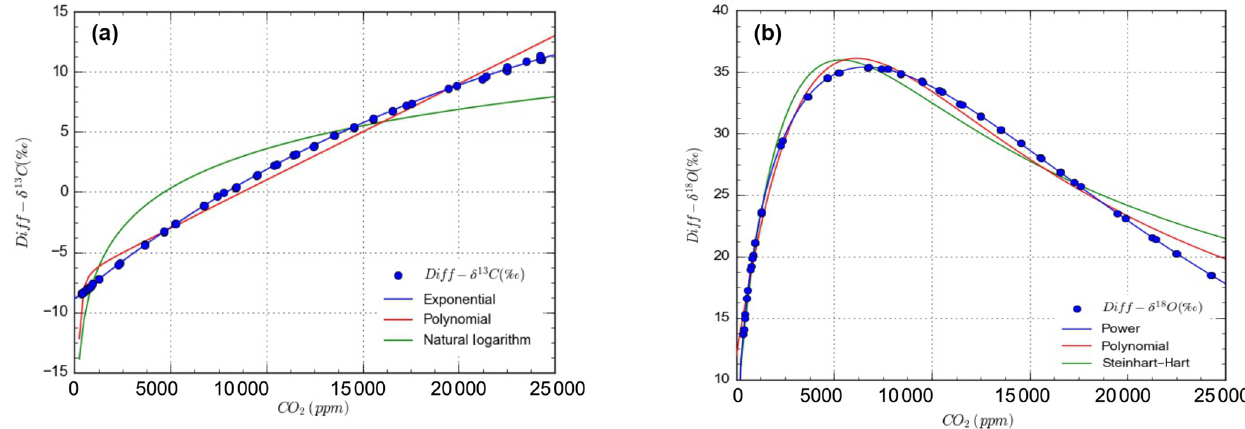
Figure 5. Mathematical models for concentration dependent drift in OA-ICOS measurements of stable isotopes of carbon (a) and oxygen (b) in CO 2 from IRMS measurements. Blue circles show Diff- δ 13 C (a) and Diff- δ 18 O (b) data points, and lines represent different mathematical models fitted on the measured data.